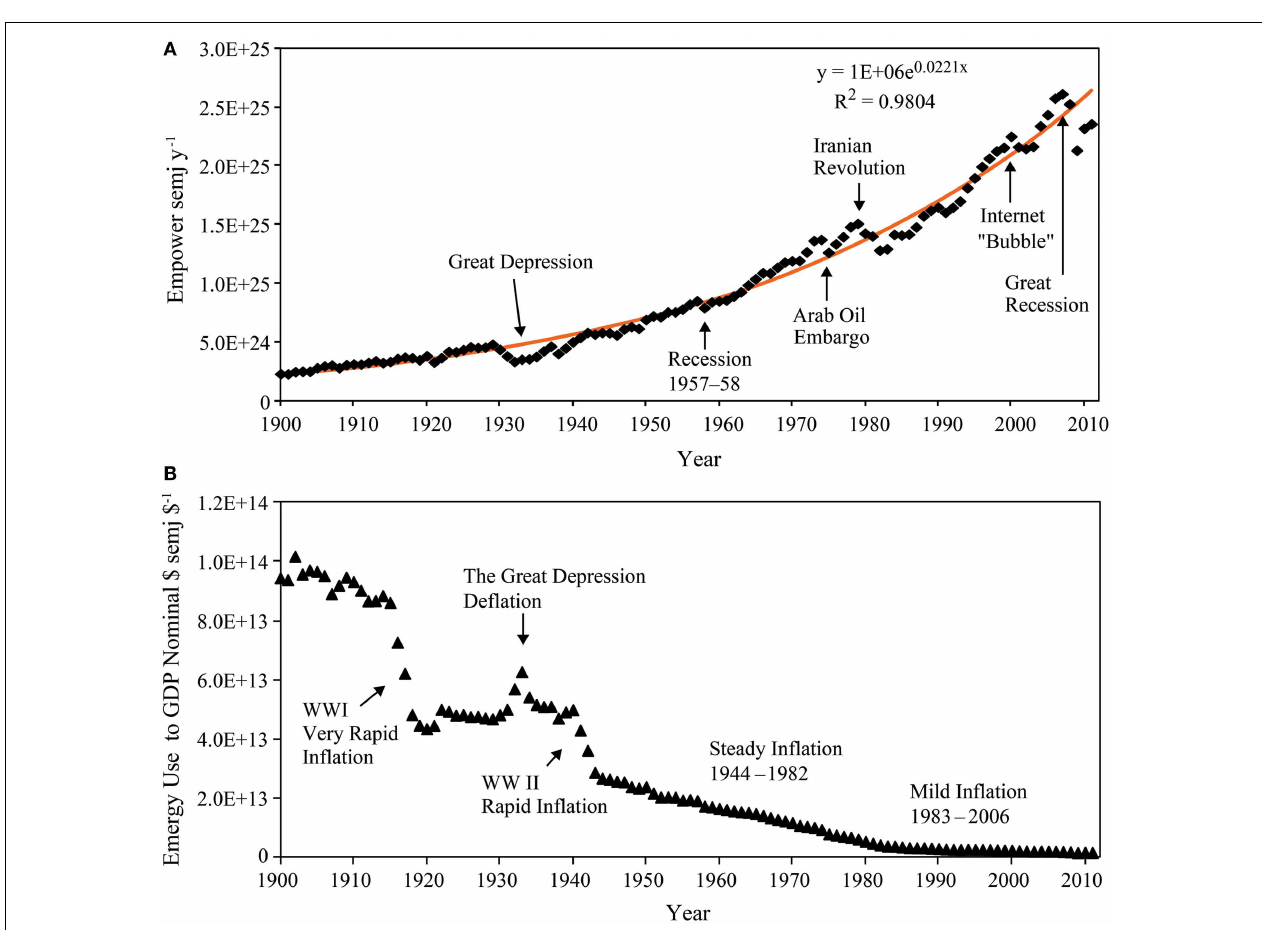
FIGURE 5 |Temporal patterns of empower and the emergy to money ratio of the U.S. (A) The growth of total emergy used in the U.S. economy with some prominent fluctuations identified. (B) The U.S. emergy to money ratio is shown with major periods of inflation and deflation